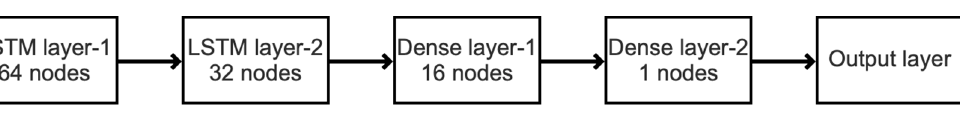
Figure 3. Unit structure of the LSTM.